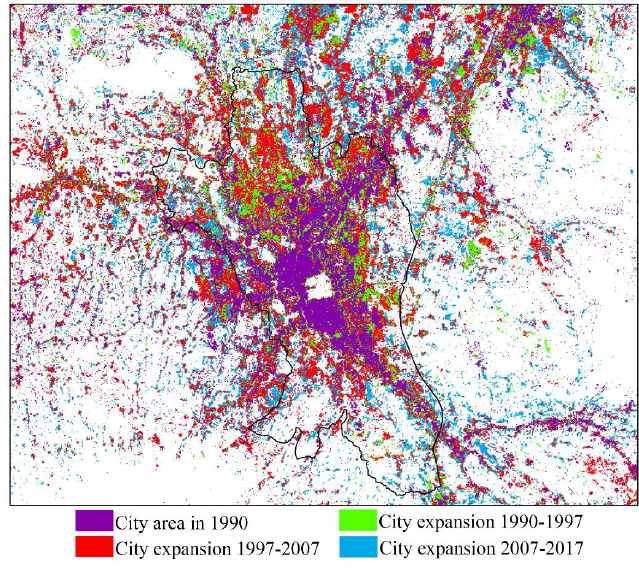
Figure 6. City expansion in 1990 – 2017.